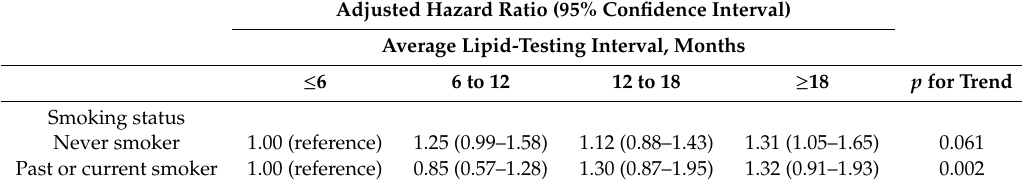
Table A1. Stratified analysis on the e ff ect of average lipid-testing interval on total stroke among newly diagnosed dyslipidemia patients according to subgroups of smoking status, physical activity, alcohol consumption, total cholesterol, body mass